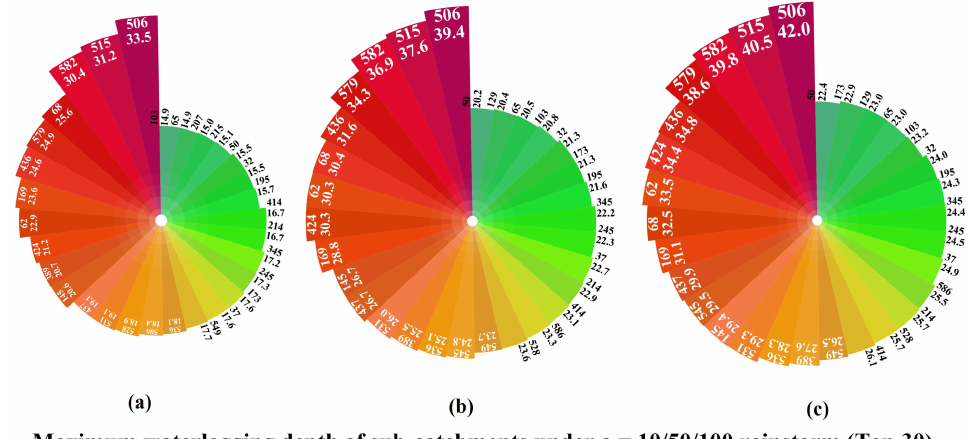
Int. J. Environ. Res. Public Health 2023 , 20 , x